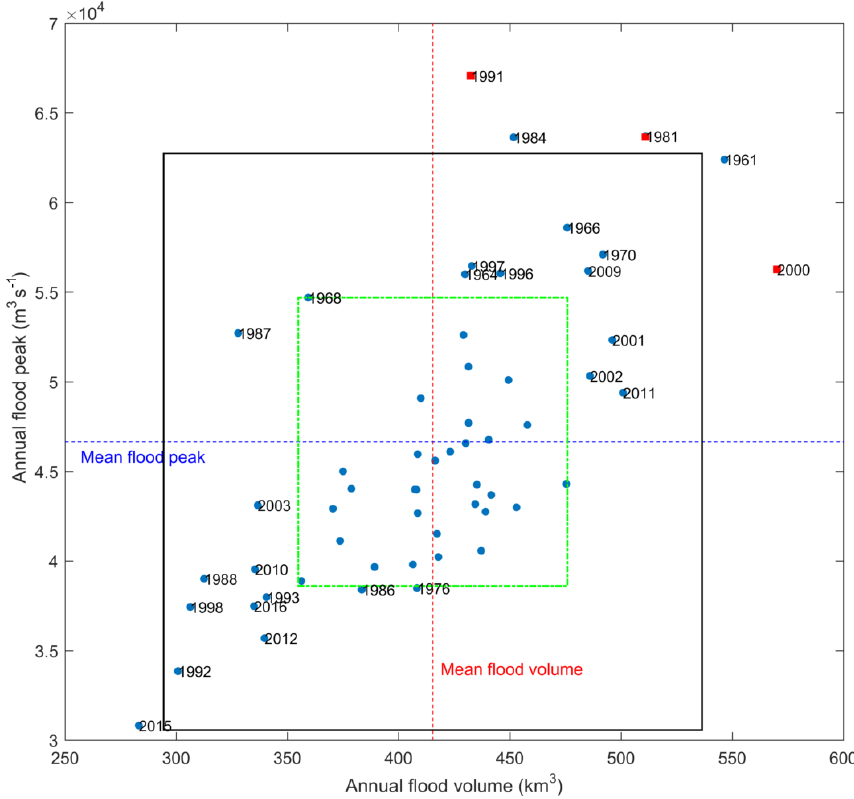
Figure 4. The annual flood peaks and volumes at Kratie from 1961 to 2017. The green and black boxes indicate significant (mean ± SD) and extreme (mean ± 2SD) drought or flood years respectively. (SD refers to standard